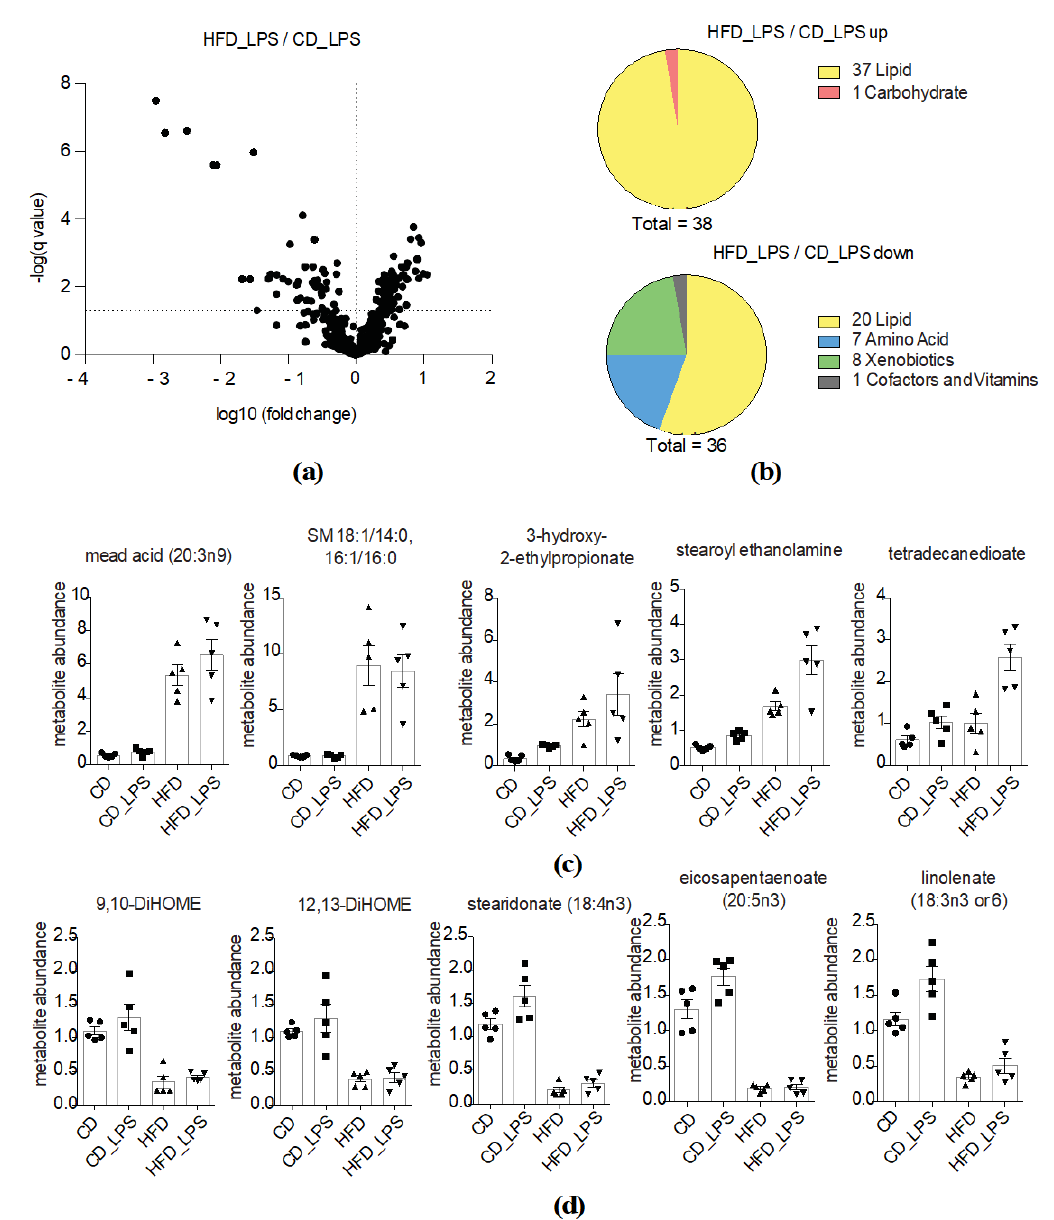
Figure 5. Synergistic effects of LPS treatment and HFD feeding on systemic metabolism. ( a ) Volcano plot indicating changes in metabolite abundances between the HFD_LPS- and the CD_LPS-treated groups ( q -value < 0.05 is considered significant). – log10 and log10 q -values and fold changes, respectively, are depicted; ( b ) Pie charts indicating numbers of altered metabolites in the HFD- compared to the CD-fed group based on their biological classification; ( c ) Abundances of significantly upregulated metabolites in the HFD_LPS-treated group compared to the CD-fed group. Individual values, means and SEM are presented; ( d ) Abundances of significantly downregulated metabolites in the HFD_LPS-treated compared to the CD-fed group. Individual values, means and SEM are presented.